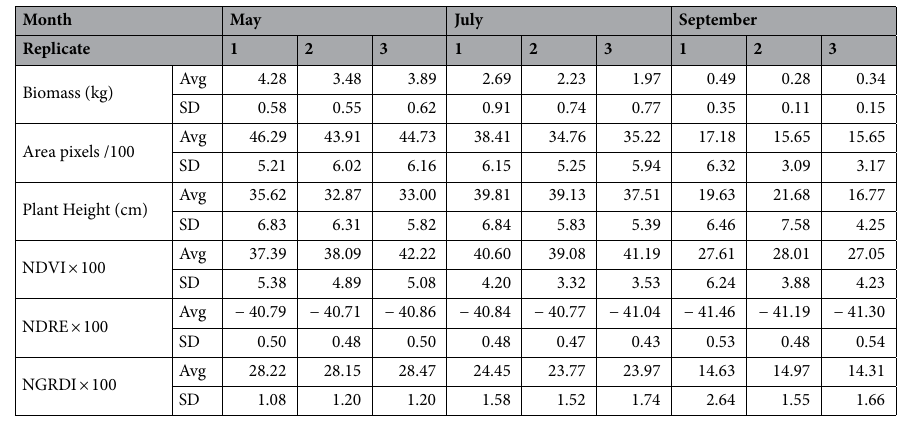
Table 1. Statistics of biomass and six image features evaluated in the first alfalfa field. Values for observed biomass and each image feature are displayed as the plot average (Avg) and standard deviation (SD) for each combination of month and